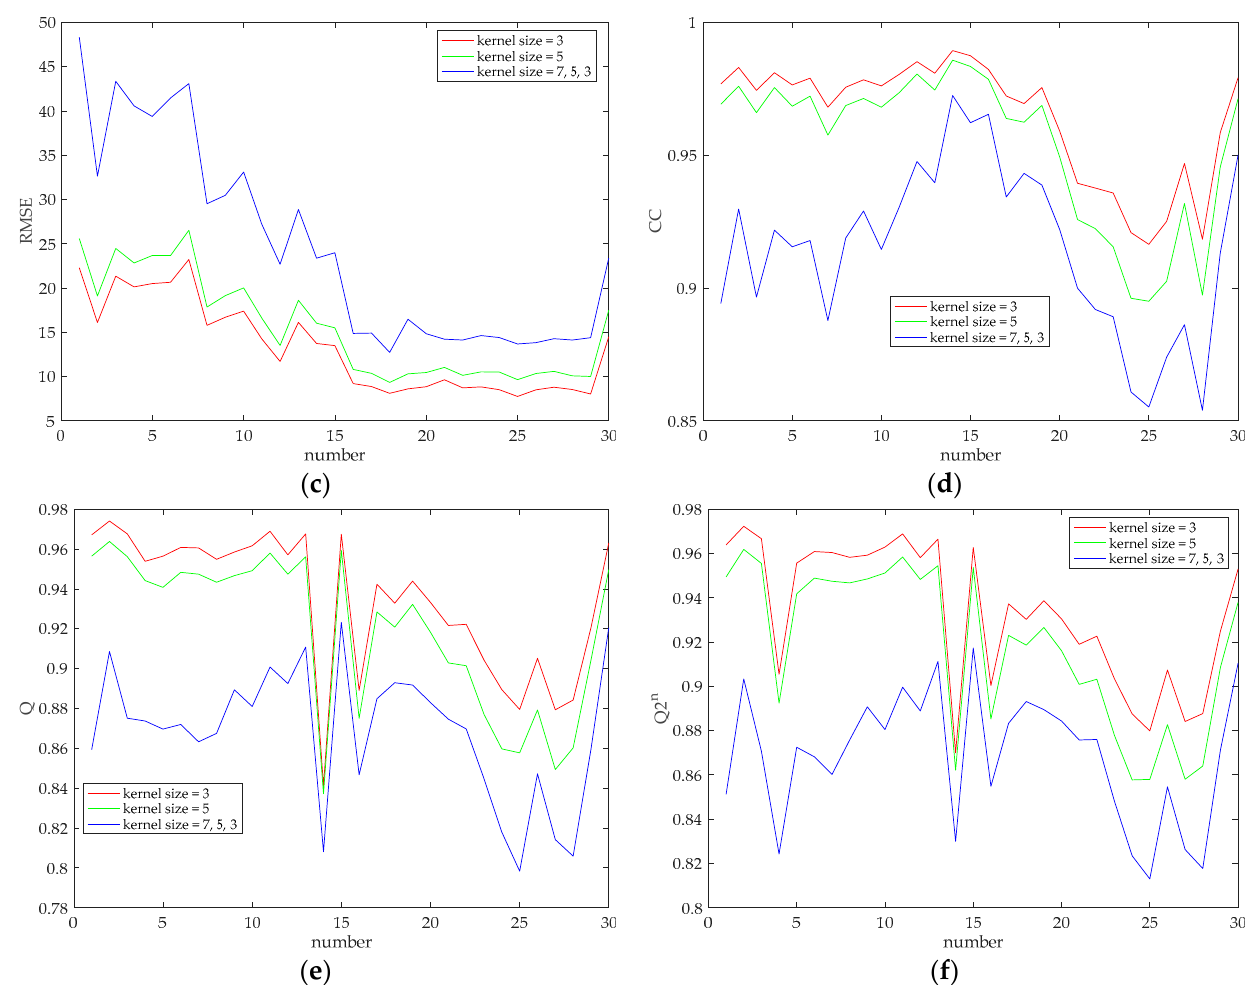
Figure 4. Quality Indicator curves of different convolution kernel sizes (evaluated on 30 groups of test images of GeoEye-1 dataset). ( a ) SAM; ( b ) ERGAS; ( c ) RMSE; ( d ) CC; ( e ) Q; ( f )